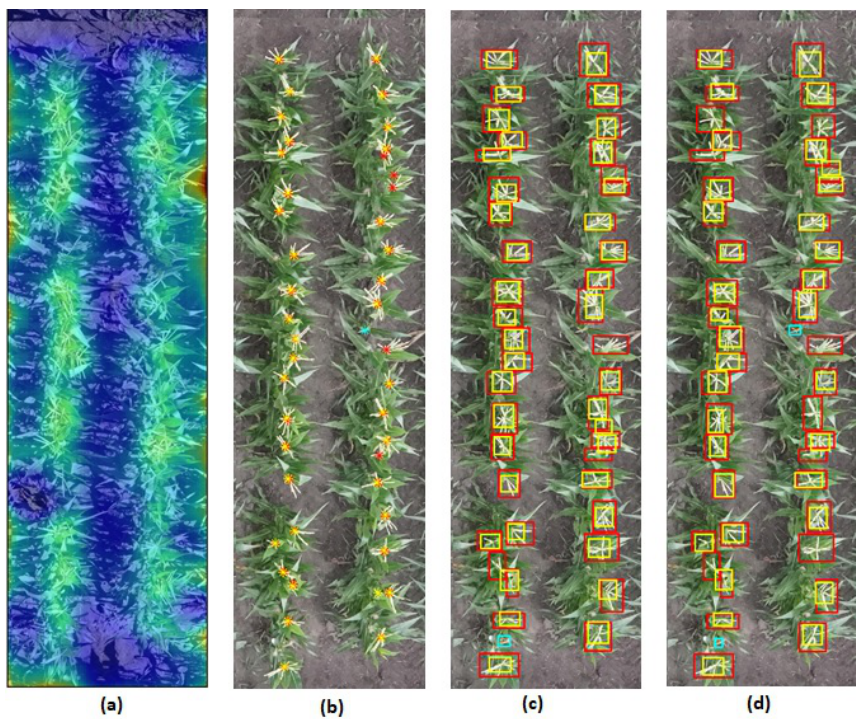
Figure 16. Results of Test Subset 15 (Ng: Red, TP: Yellow, FP: Cyan). ( a ) TasselNetv2+. ( b ) CenterNet. ( c ) TSD. ( d )